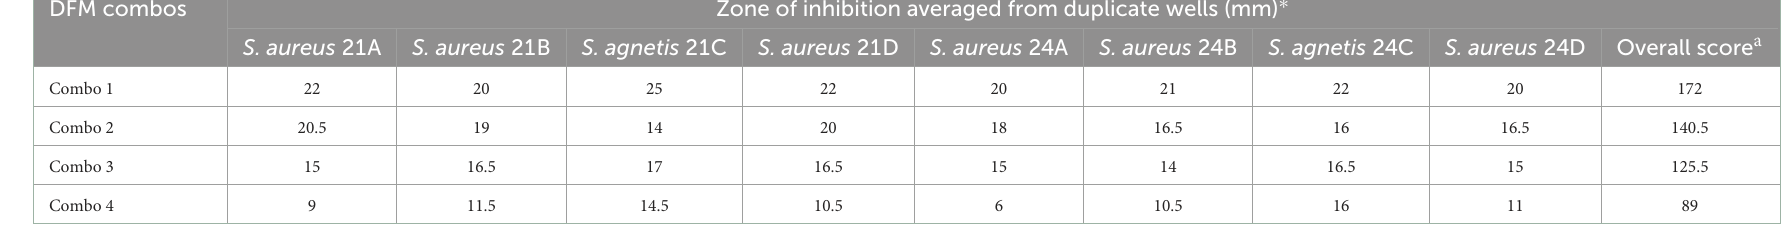
TABLE 4 Antimicrobial activity, by agar-well diffusion, of proprietary DFM combination against S. agnetis and S. aureus isolated from skin of FUDS + birds. DFM combos